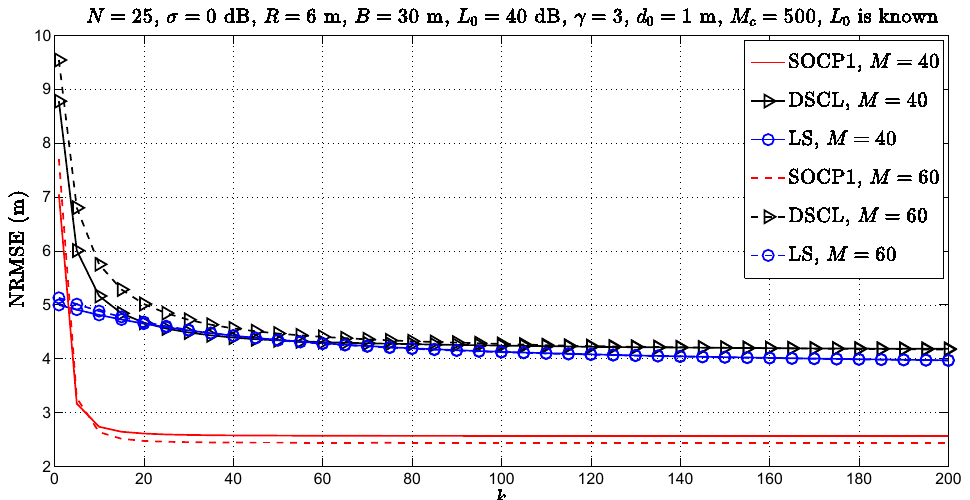
Figure 4. Simulation results for cooperative localization when L k comparison for different M , when N = 25 , σ = 0 dB, R = 6 m, B = 30 m, L γ = 3 , d = 1 m, M = 500 0 c